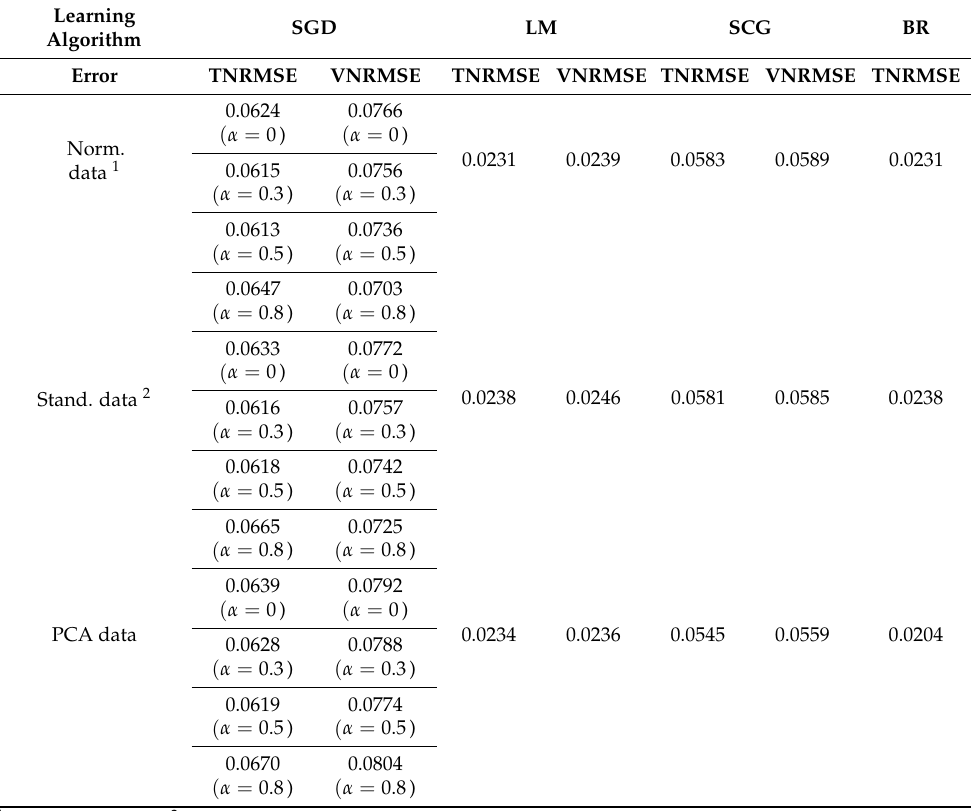
Table 4. The obtained results for training and validation errors for different learning algorithms. Learning